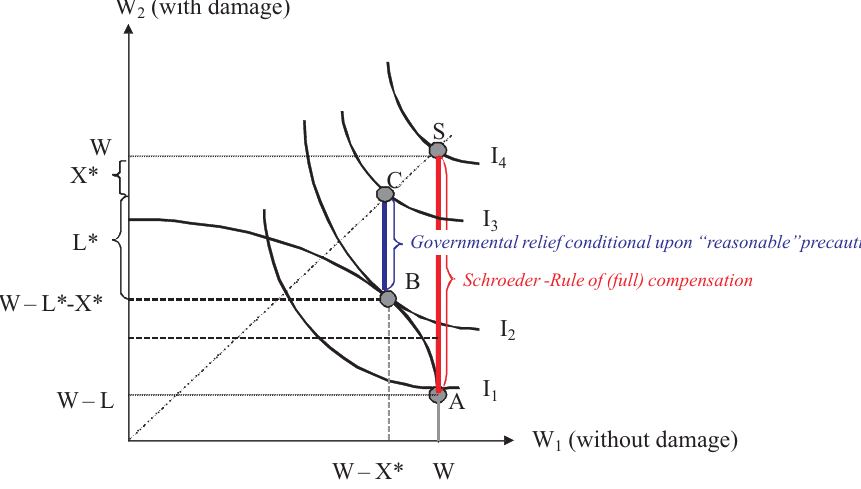
Fig. 1. Basic economic model of precaution and governmental relief relating to damages caused by natural